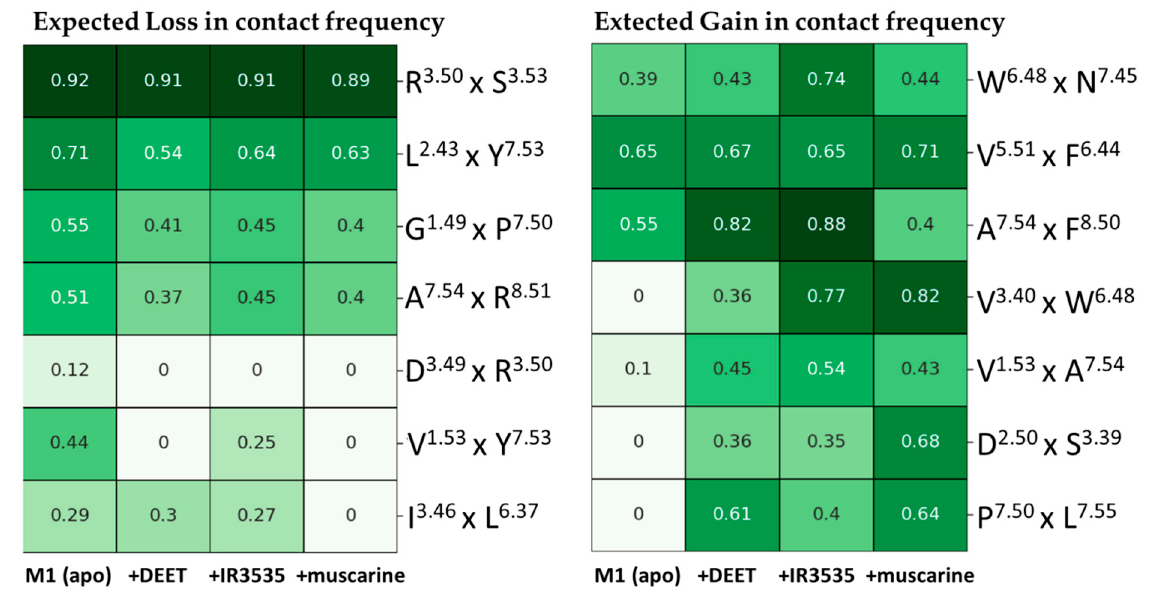
Figure 3. Average contacts as a fraction of total simulation time (450 ns) [52] observed for M1 apo and for M1 having DEET, IR3535, and muscarine ligands in the orthosteric site. Table 1. Parametrization of global effects of ligands on averaged contact fractions.